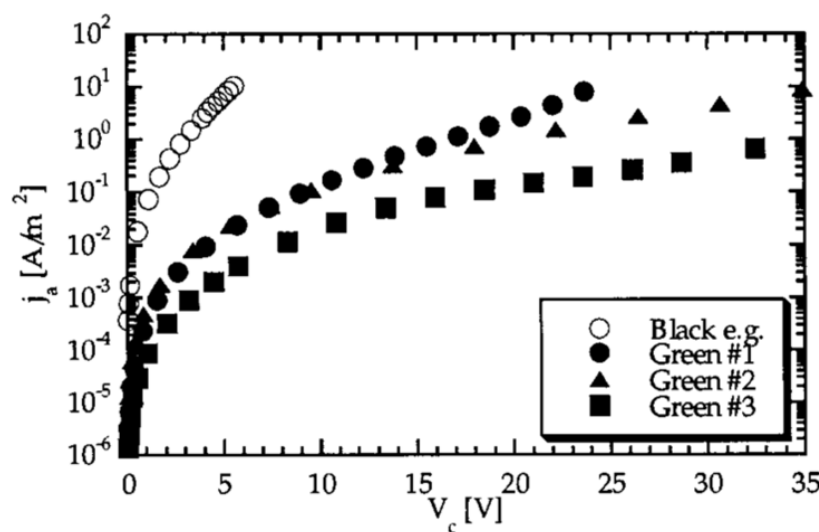
Figure 20. Current density as a function of voltage for black and green SiC. Reprinted with permission from ref. [64] Copyright 2001 AIP Publishing.